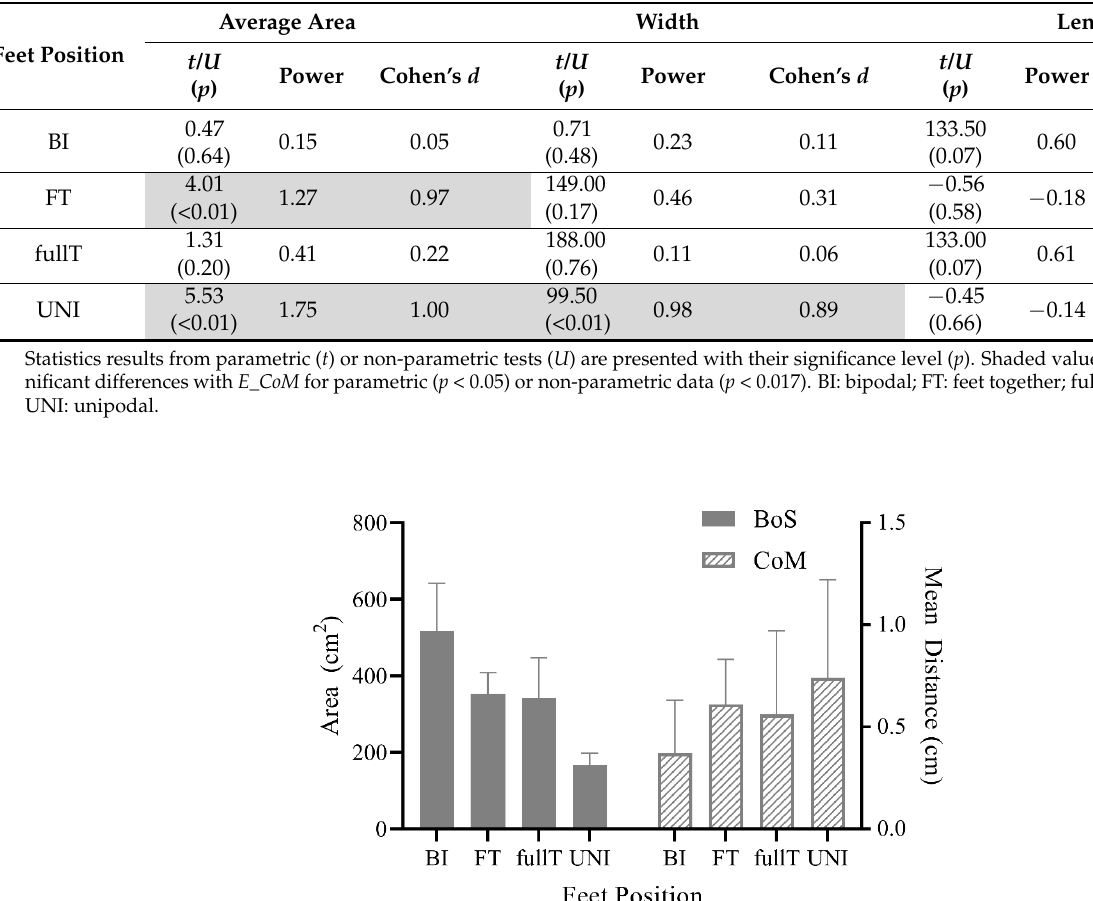
Table 9. Statistical results, power, and effect size of the base of support parameters between the Equimetrix device and the pressure mat.